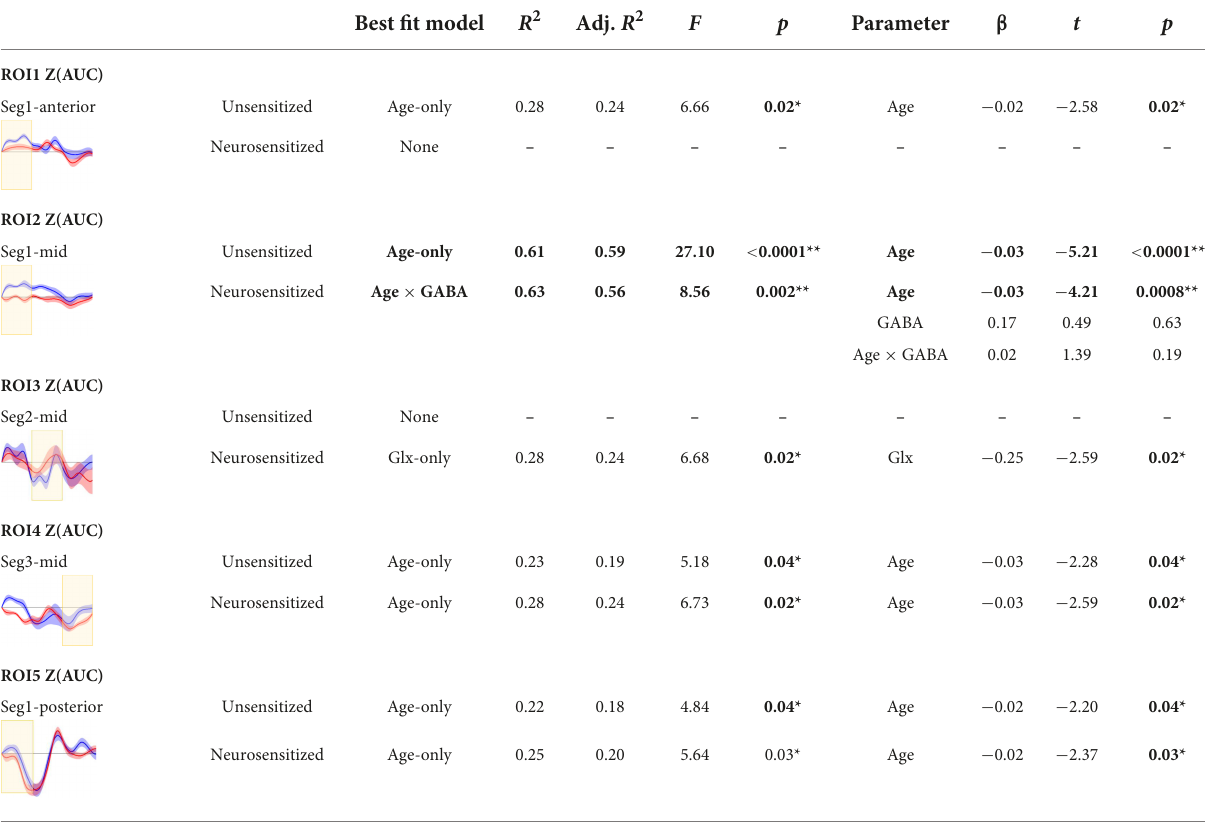
TABLE 3 Best fit ROI-level neurophysiological model for BOLD